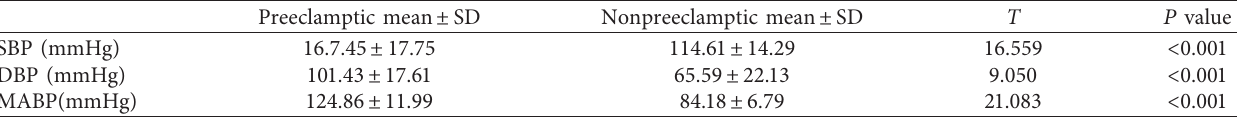
Table 4: Comparison of mean blood pressure between preeclamptics and nonpreeclamptics